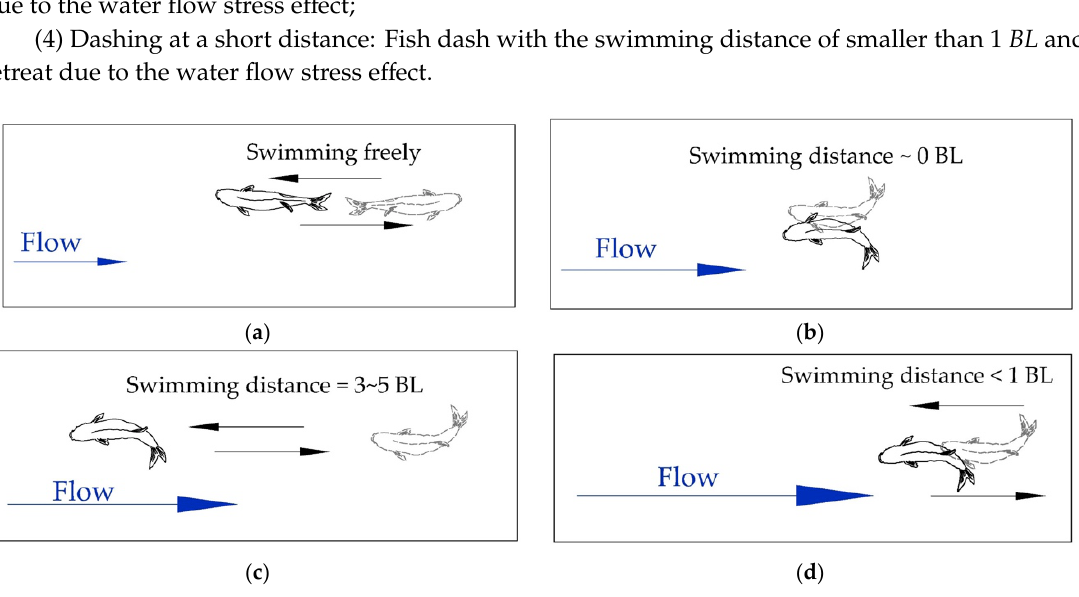
Figure 3. Classification of fish swimming behaviors under incremental water velocity: ( a ) Swimming freely; ( b ) Staying; ( c ) Dashing at a long distance; ( d ) Dashing at a short distance.